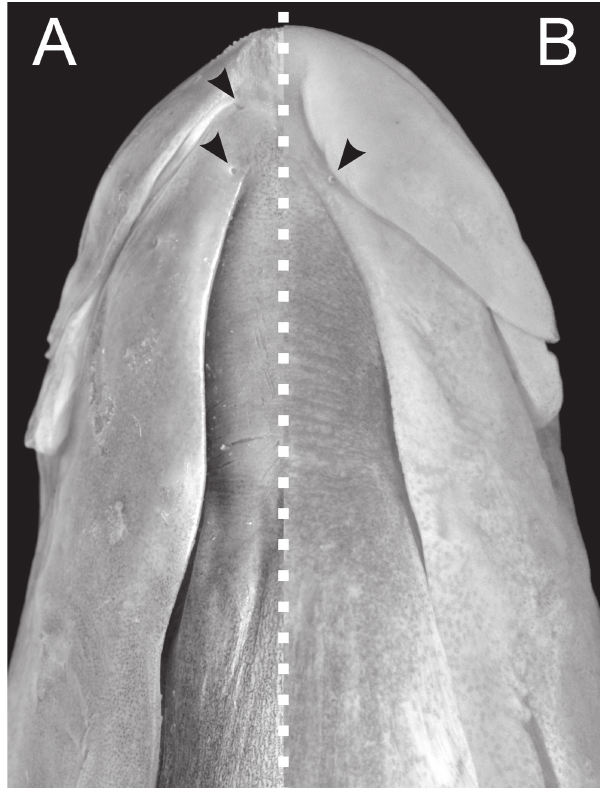
Fig. 3. Ventral view of head, showing the shape of lips, in (A) Geophagus mirabilis , paratype, UFRO-I 21285, 151.6 mm SL, Brazil, State of Mato Grosso, município de Aripuanã, rio Aripuanã, upstream from Dardanelos/Andorinhas falls; (B) G. camopiensis , MZUSP 32888, 112.6 mm SL. Arrow heads indicate lateralis foramina 1 and 2 in (A) and lateralis foramen 2 in (B). Photograph by Celso Ikedo.